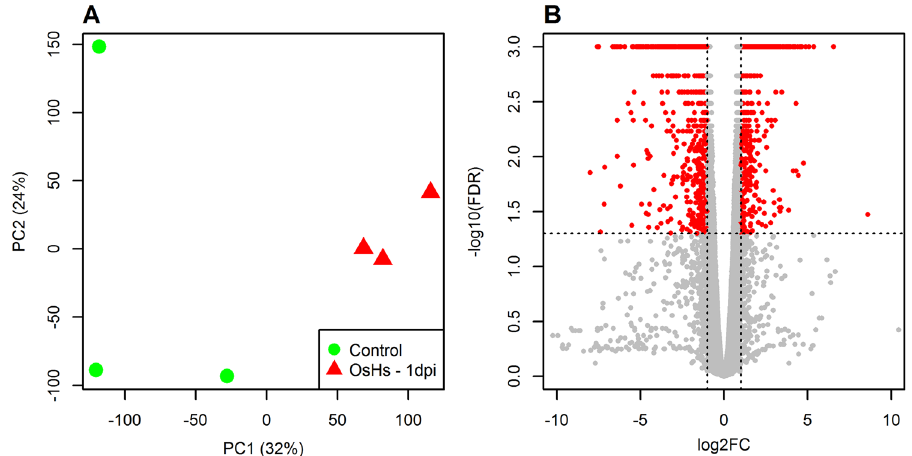
Figure 2. Summary plots for the gene expression profiles and differential expression analysis. ( A ) Shows a scatter plot of the two principal components of the FPKM normalized gene expression profiles. ( B ) Shows a volcano plot where mean log 2 fold change is plotted against the − log 10 FDR adjusted P-values for all the expressed genes. Significant differentially expressed genes (FDR < 0.05 and |log 2 FC|> 1) are highlighted in